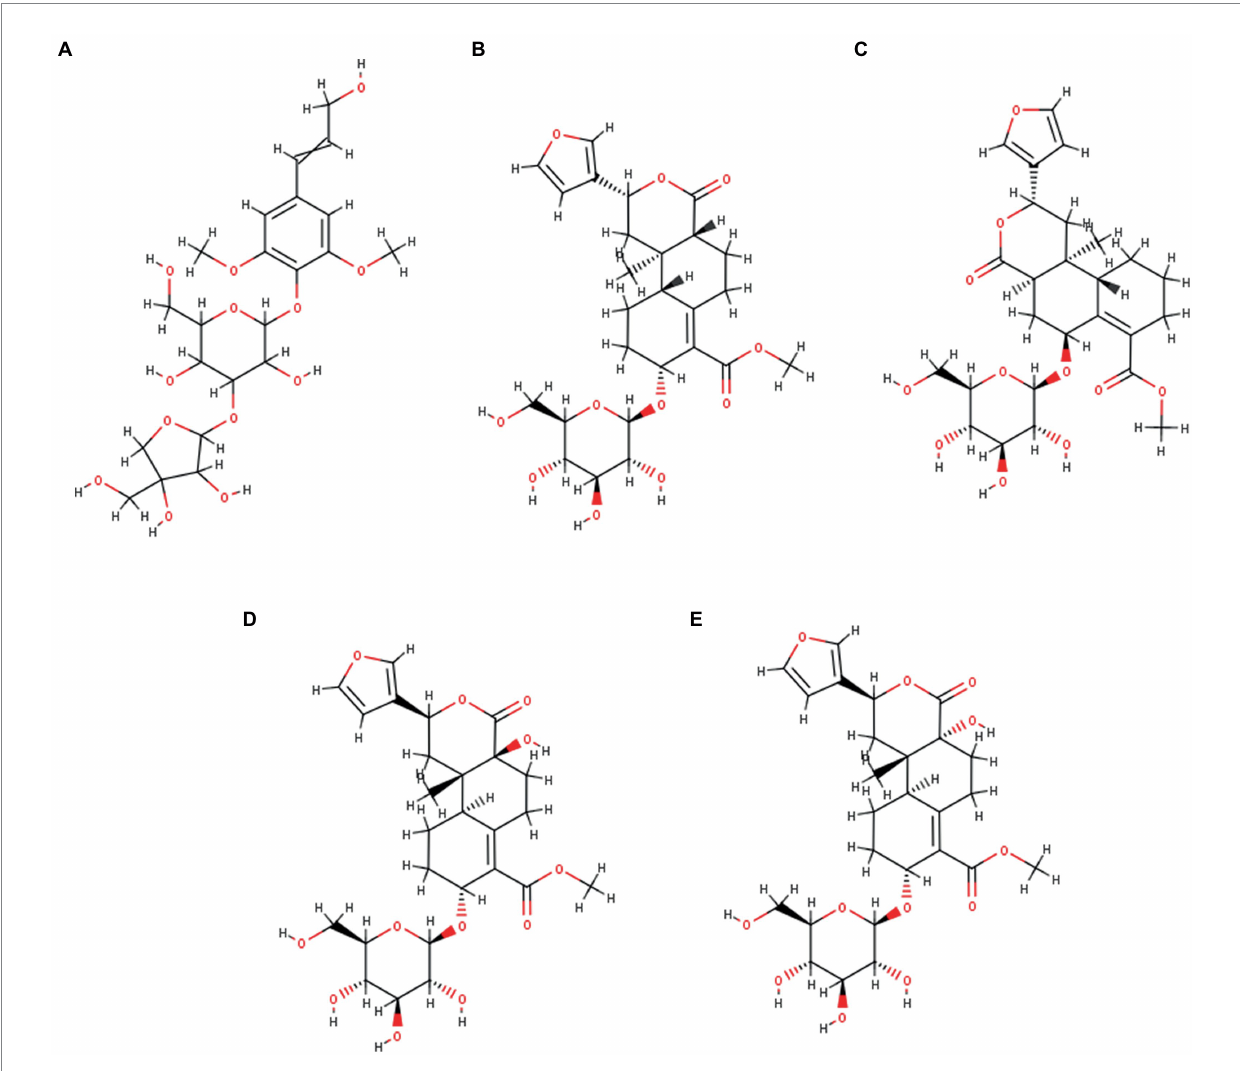
FIGURE 3 Five Cordifoliside compounds, (A) Cordifoliside A, (B) Cordifoliside B, (C) Cordifoliside C, (D) Cordifoliside D, (E) Cordifoliside